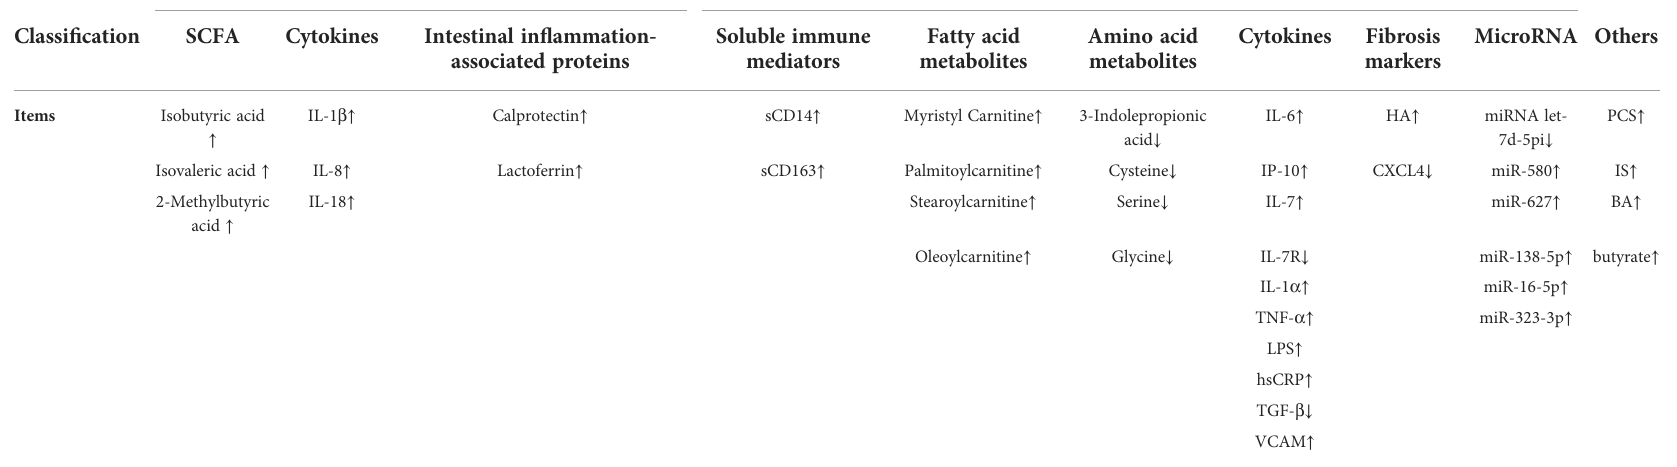
TABLE 2 Summary of circulating marker changes in